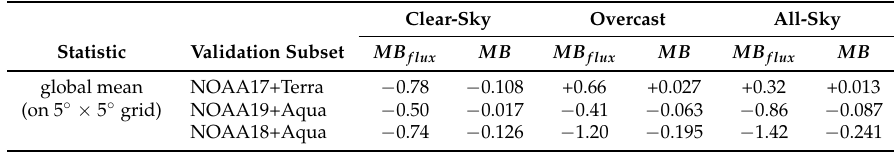
Table 7. Global stability statistics from bias map, based on expanded database (with relaxed matching criteria) for clear, overcast, and allsky conditions; Validation data is stratified per satellite combination,